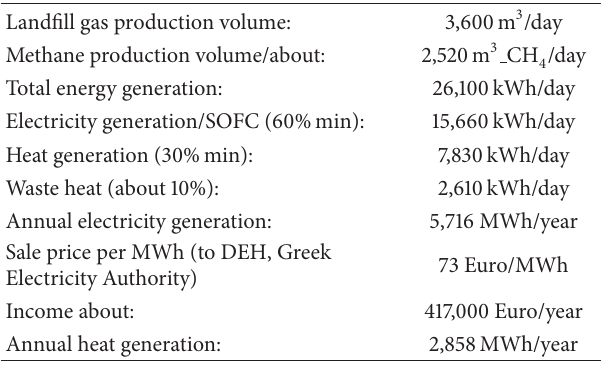
Table 1: Specifications of a representative small landfill gas- reforming SOFC system, for electricity and heat